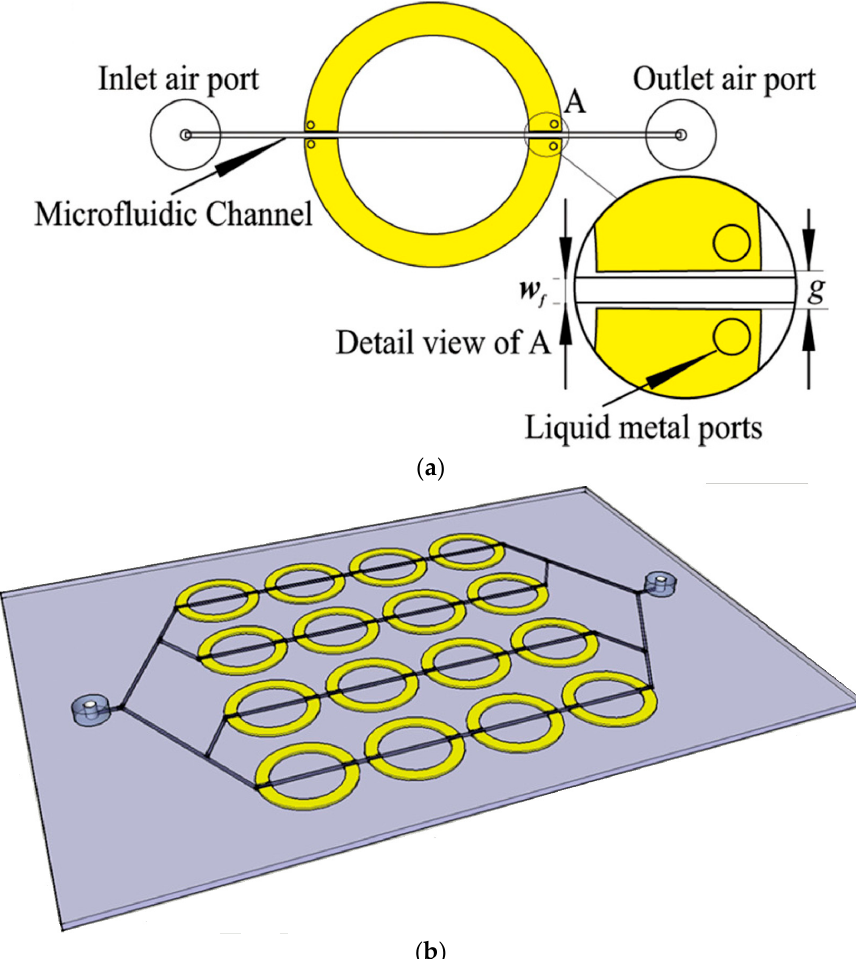
Figure 7. ( a ) Illustration of a unit cell meta-atom SRR based fully integrated microfluidic sensor with g = 0.8 mm, and w f = 0.4 mm; and ( b ) an integrated meta-surface SRR based sensor, consisting of 16 unit cells (redrawn from [40] ).